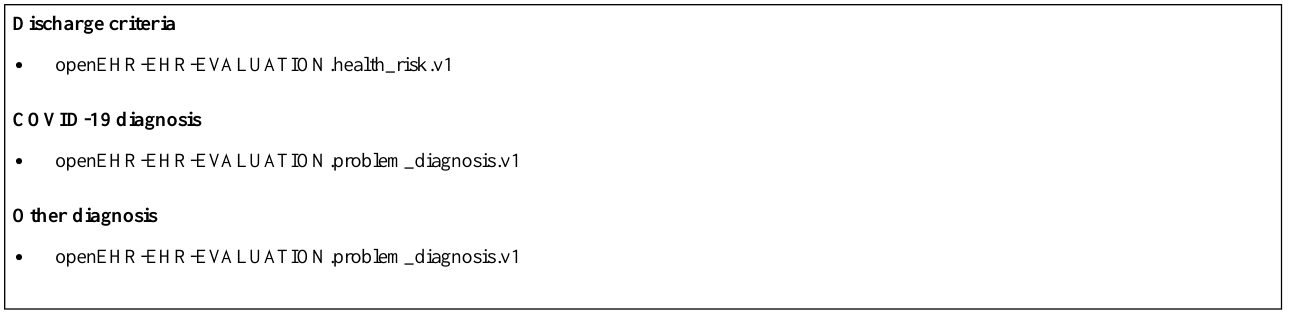
Figure 4. The developed template in Ocean Template Editor. COVID-19: coronavirus disease; CT: computed tomography; ESR: erythrocyte sedimentation rate; SARS: severe acute respiratory